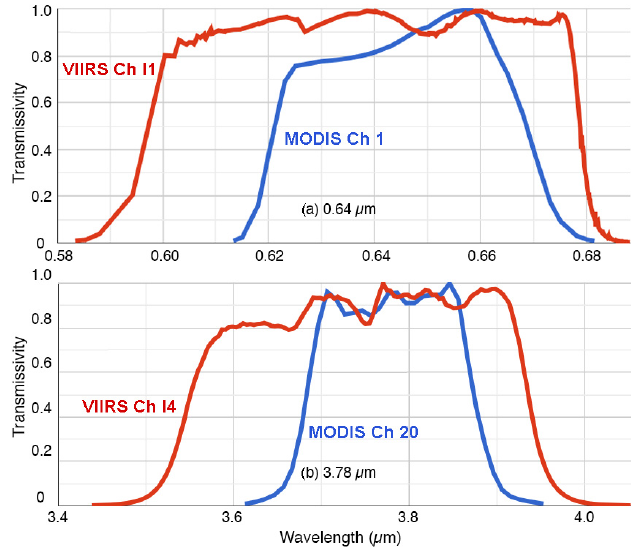
Figure 1. Spectral response functions for CERES channels ( a ) 1 and ( b ) 3 used in cloud detection and retrieval algorithms.